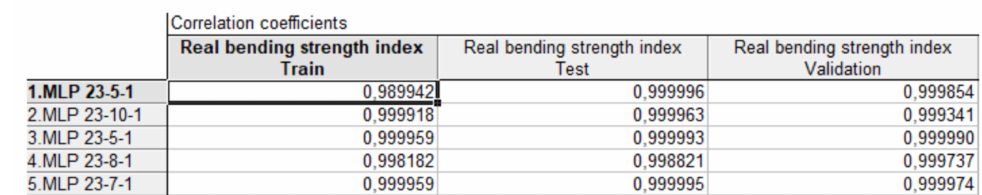
Figure 25. Validation table.